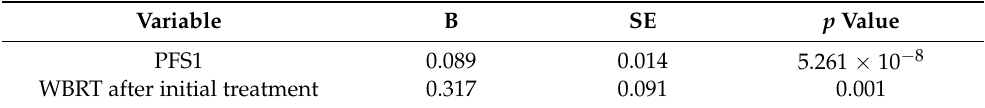
Table 4. Regression analysis of the response to HD-MTX rechallenge treatment with significant clinical